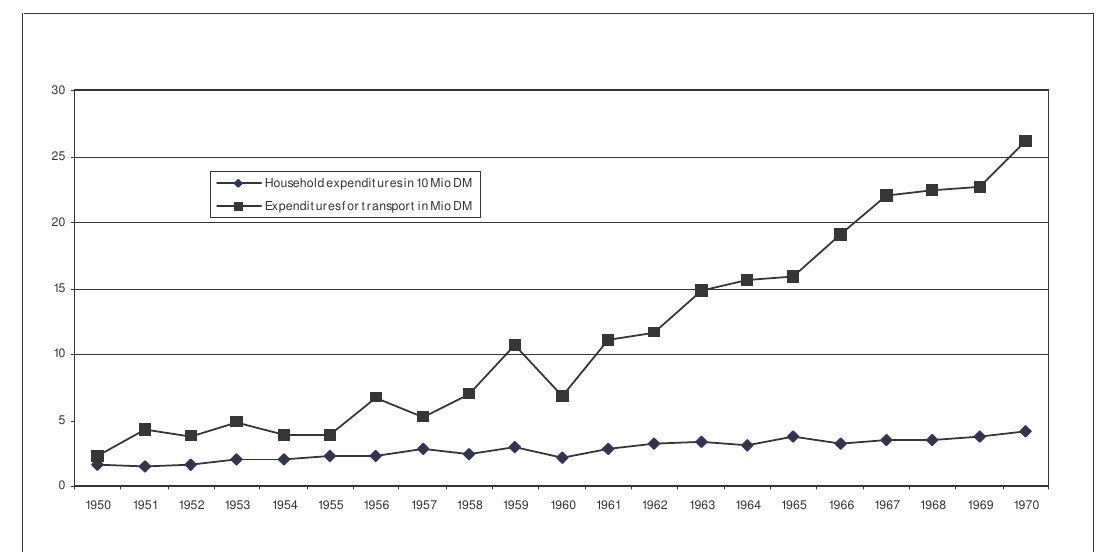
Figure 2. Expenditure on transport: City of Bielefeld and Stadtwerke Bielefeld 1950-70 (prices from 1985). Source: Haefeli 1998 .